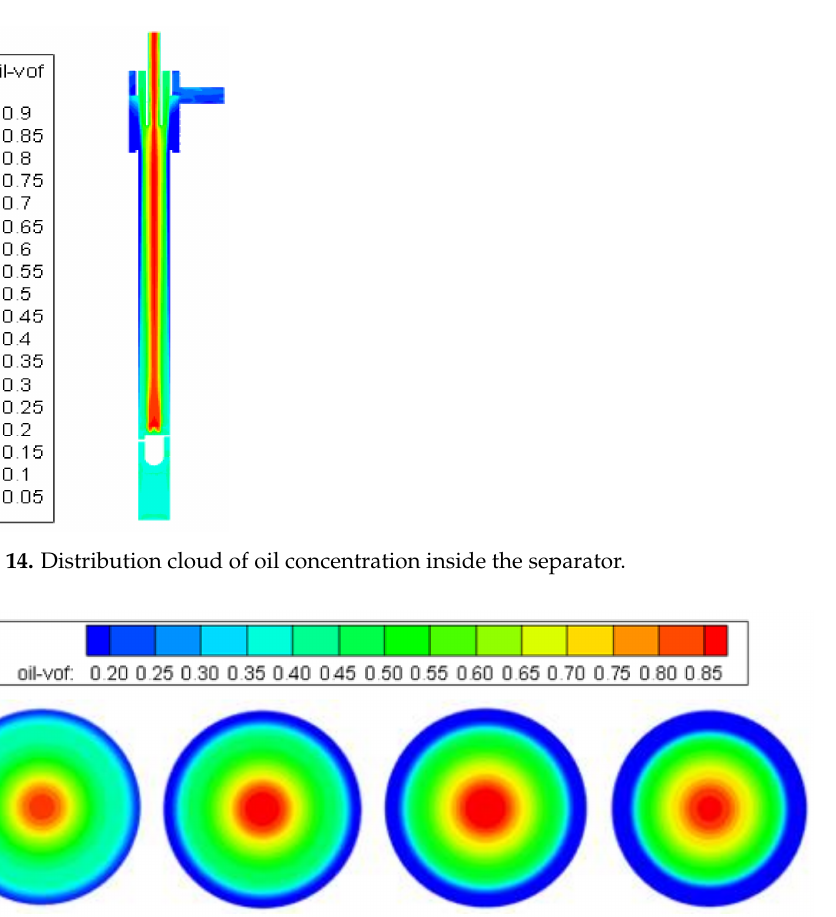
Figure 13. Radial distribution curves of pressure in different cross sections.